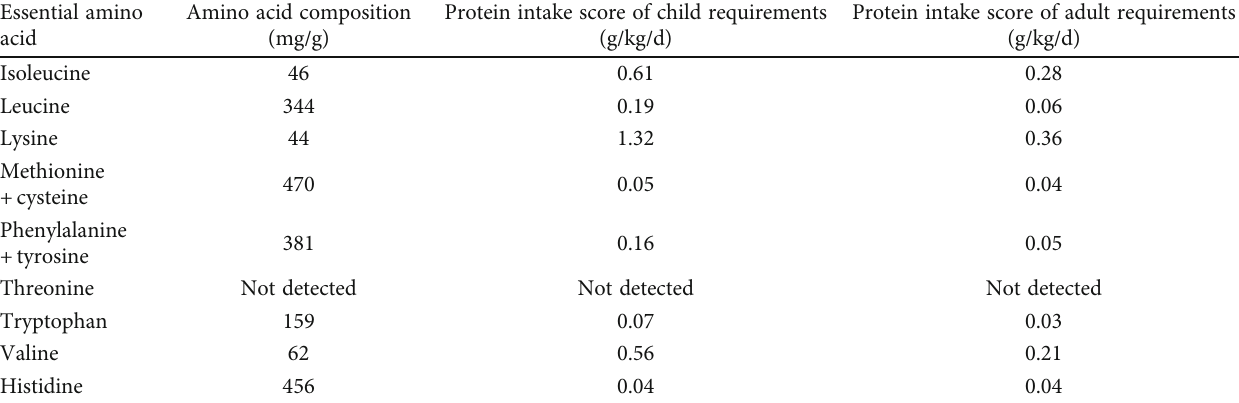
Table 4: Protein quality index and score of mesquite